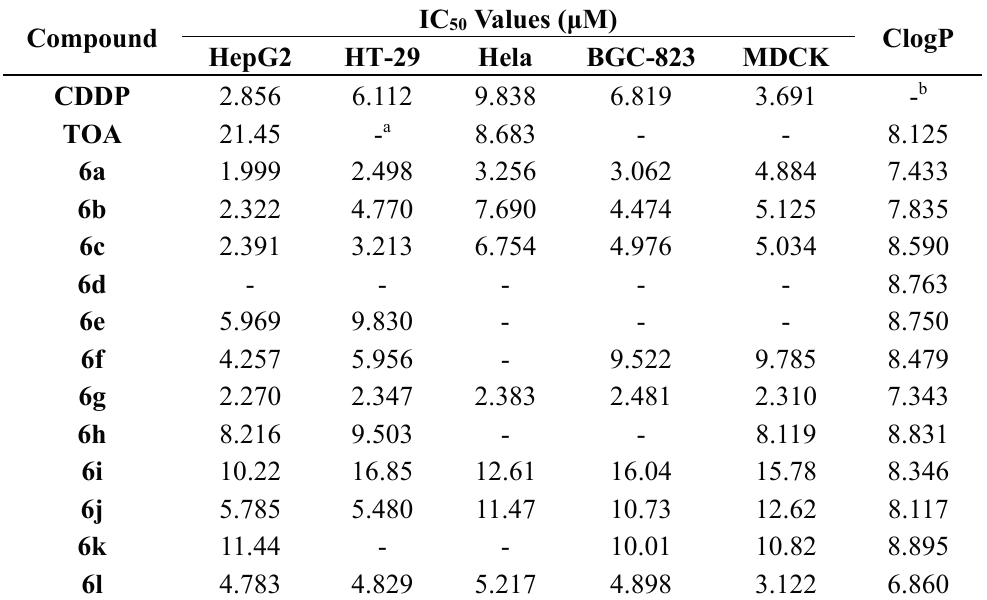
Table 1. Anti-proliferative effects and ClogP values of TOA-amino acid derivatives.